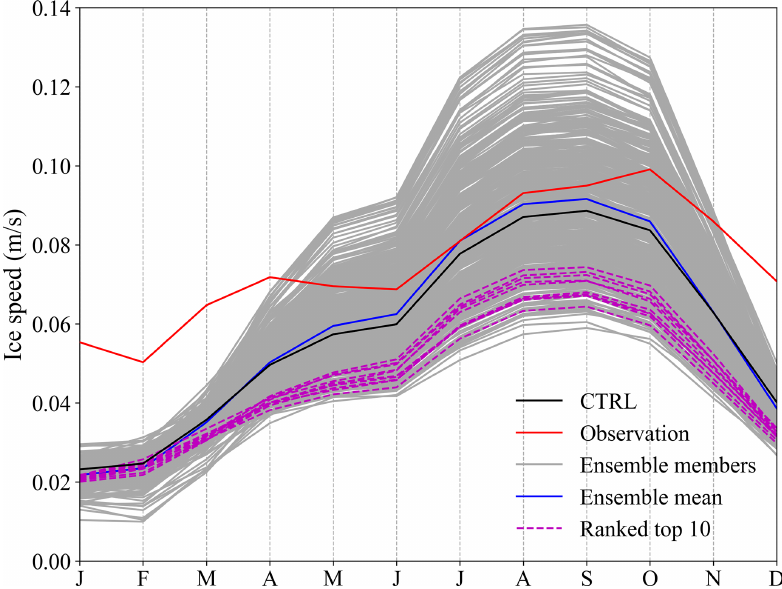
Figure B7. Sea ice speed seasonal cycles for the observation (Kimura et al., 2013) and simulations over 2008–2017. The simulated sea ice velocities are first interpolated onto the KIMURA data grid, then the spatial average of the ice speed is calculated in the areas where observations are available. The ice speeds of the 10 experiments with the closest SIC budget to the observation are marked with dashed magenta lines.